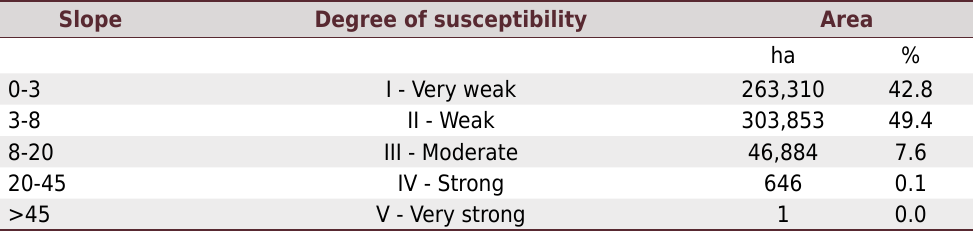
Table 4. Degree of susceptibility according to classes of slope in the municipality of São Miguel do Araguaia, state of Goiás, Brazil Slope